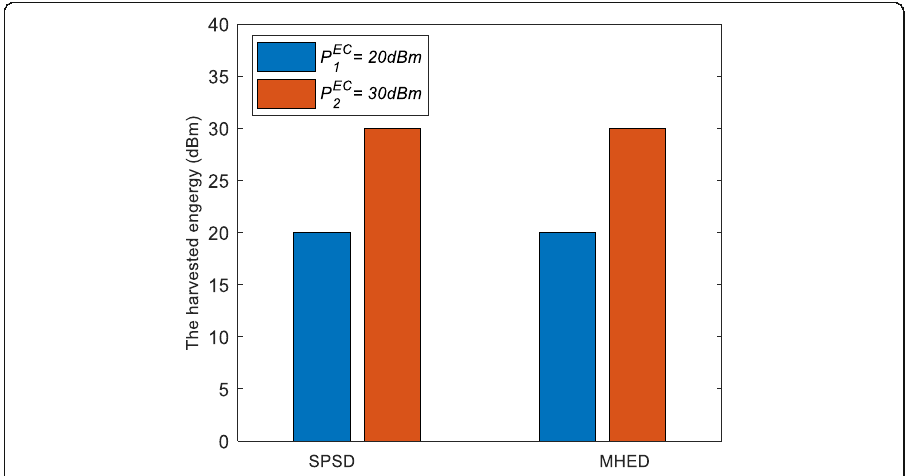
Fig. 8 The harvested energy achieved by two optimization schemes. The blue histograms represent the harvested energy achieved by MHED and SPSD, when energy collection constraints P EC orange histogram represents the harvested energy achieved by MHED and SPSD, when energy collection